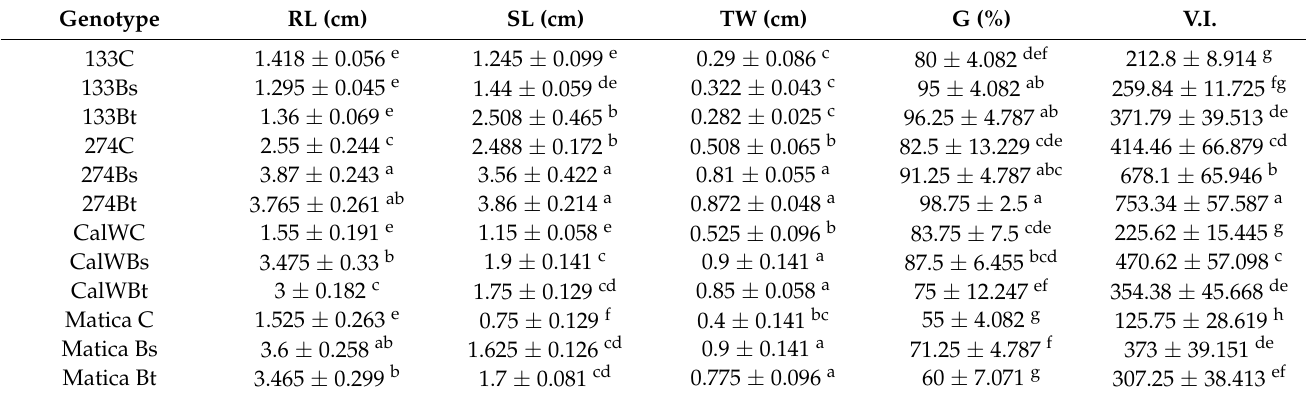
Table 1. Duncan’s test of pepper growth parameters treated with Bacillus safensis SS-2.7 (Bs) and B. thuringiensis SS-29.2 (Bt)